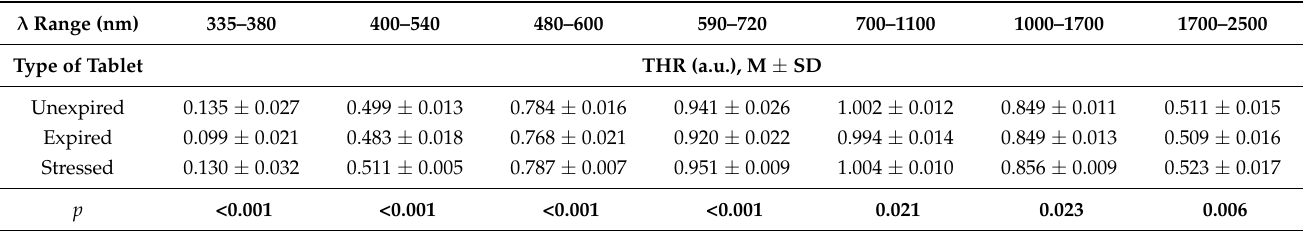
Table 1. Mean values of THR of the analyzed tablets containing